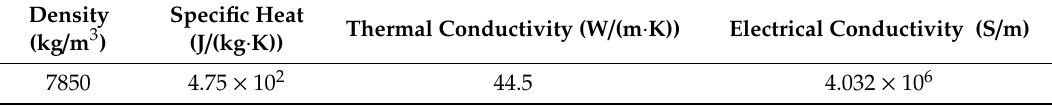
Table 2. Physical properties of stainless